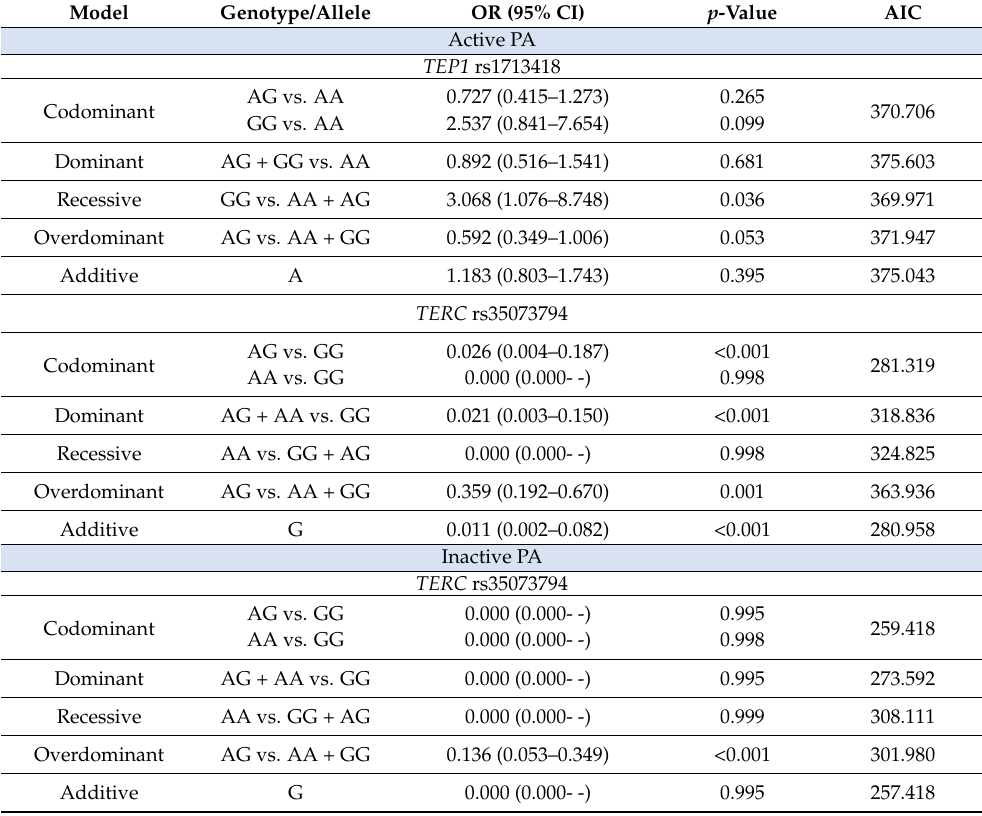
Table 5. Binary logistic regression analysis within active or inactive PA and control group